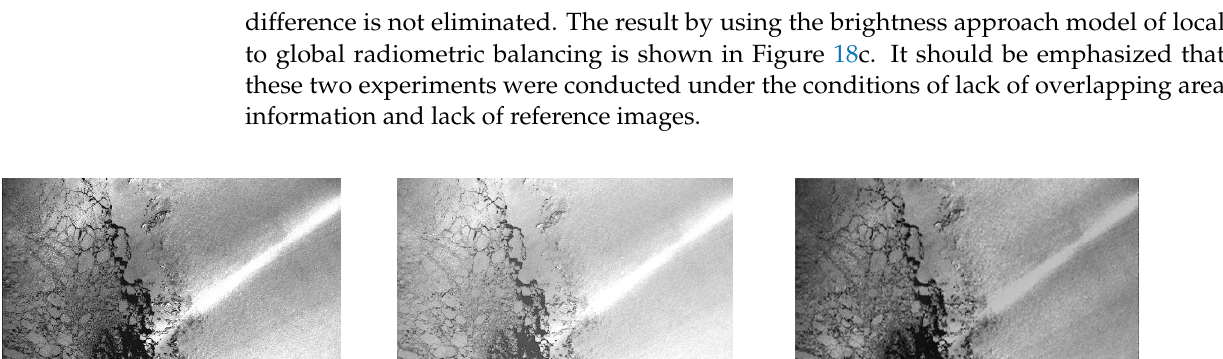
16 of 20 Figure 16. The process of local to global brightness balancing. ( a ) Original image. ( b ) The result after using brightness compensation model of local to global radiometric balancing. ( c ) The result after using brightness approach model of local to global radiometric balancing. ( d ) The result after feathering. 4. Discussion Compared with the results by different methods and the original image, we discuss